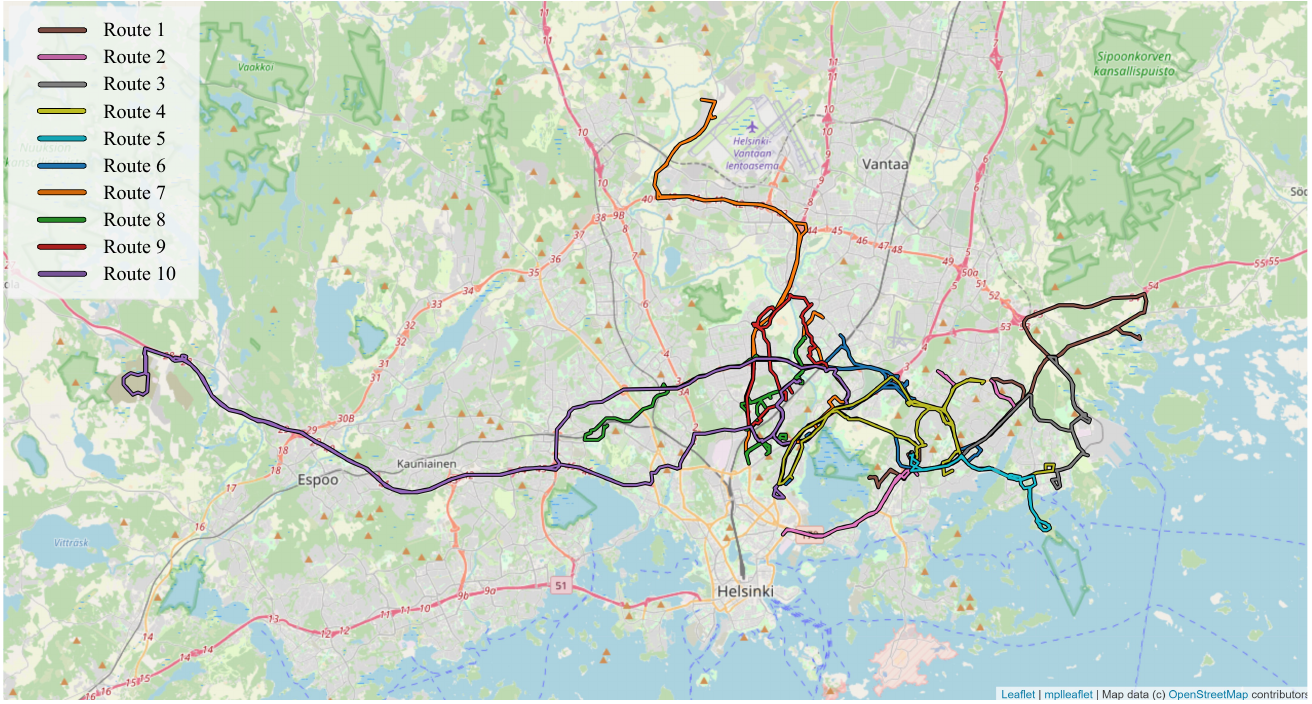
Figure 9. Simulated routes located on the map of the capital area of